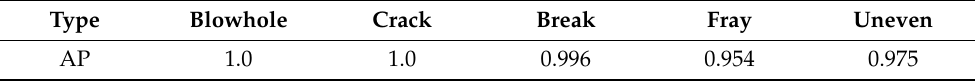
Table 6. The method is mentioned on the MT dataset with AP of different defects.